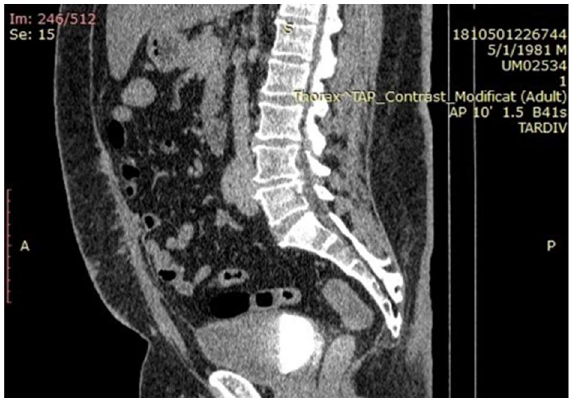
Figure 5. CT examination revealed no local tumoral recurrence or adenopathies.